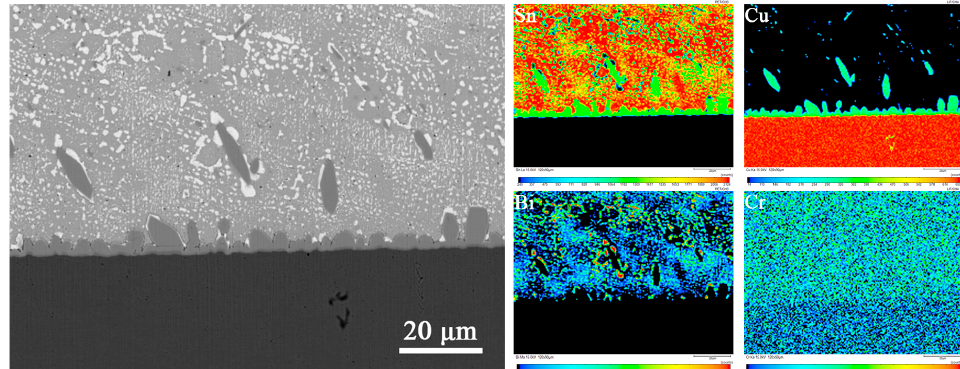
Figure 6. EPMA of Sn-0.7Cu-10Bi-0.2 wt.% Cr.